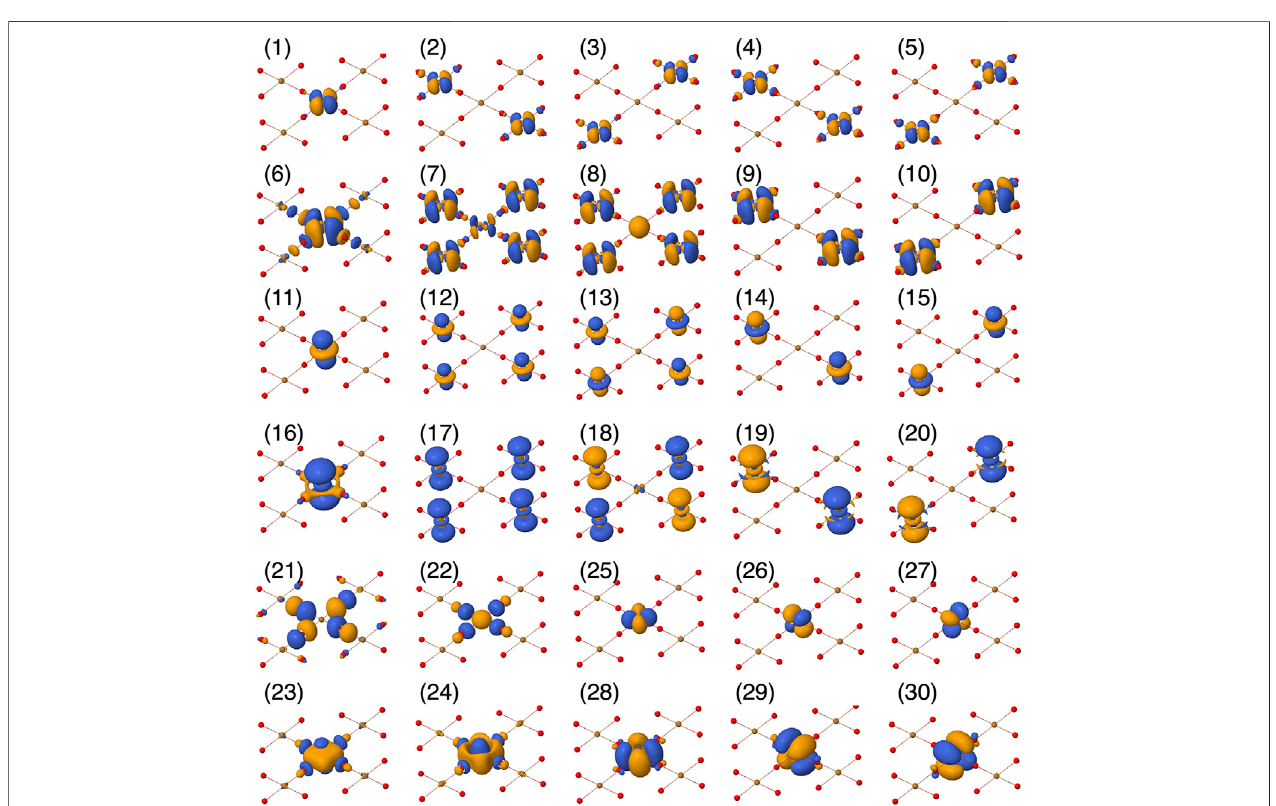
FIGURE 2 | Active orbital basis used in the CASSCF calculations, plotted using Jmol [54].